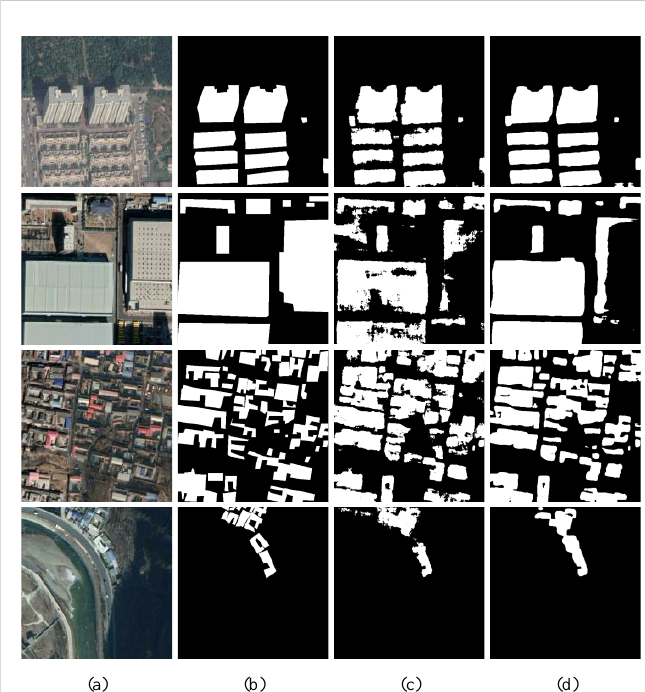
Figure 10. Examples of segmentation results with the SegNet and NAS-HRIS, respectively, on the